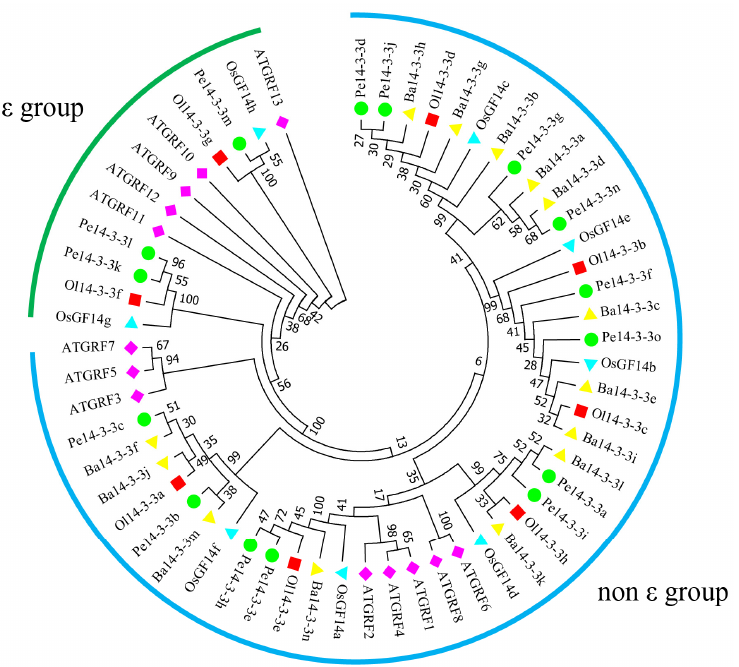
Figure 1. Phylogenetic tree of 14-3-3s in five plant species (At: A . thaliana ; Ba: B . amplexicaulis ; Ol: O . latifolia ; Os: O . sativa ; Pe: P . edulis ). The phylogenetic tree was constructed via the maximum-likelihood (ML) method (1000 bootstrap replicates) using MEGA 7.0 software. The different numbers at nodes represent the bootstrap values for homologous genes. Purple prismatic: A . thaliana ; yellow triangle: B . amplexicaulis ; red square: O . latifolia ; blue triangle: O . sativa ; green circle: P . edulis ; green and blue arcs: ε and non- ε groups.